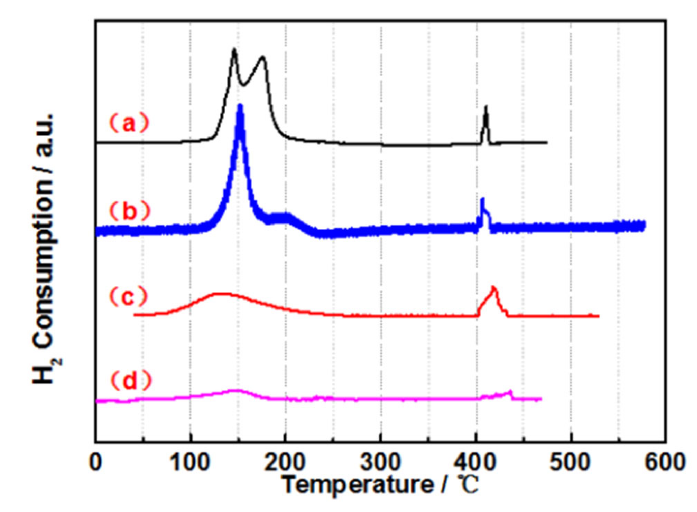
Figure 2. H 2 ‐ TPR spectra of the amorphous alloy catalysts: (a) Ru1.0Co7P20/C, (b) Figure 2. H 2 -TPR spectra of the amorphous alloy catalysts: (a) Ru1.0Co7P20/C, (b) Ru1.0Co17.5- Ru1.0Co17.5P20/C, (c) Ru1.0Co17.5P33.5/C and (d) Ru0.2Co7P20/C. P20/C, (c) Ru1.0Co17.5P33.5/C and (d)